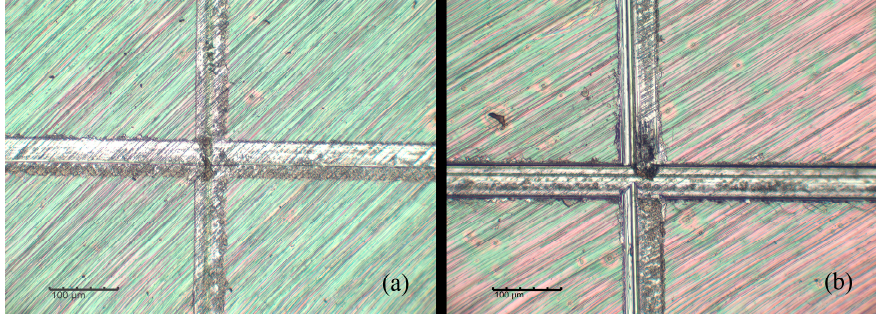
Figure 3. Optical microscopy (OM) images of beech coating ( a ) and spruce coating ( b ) after cross cut test. Smooth edges of cuts can be seen for both coatings (scale bar: 100 µm).